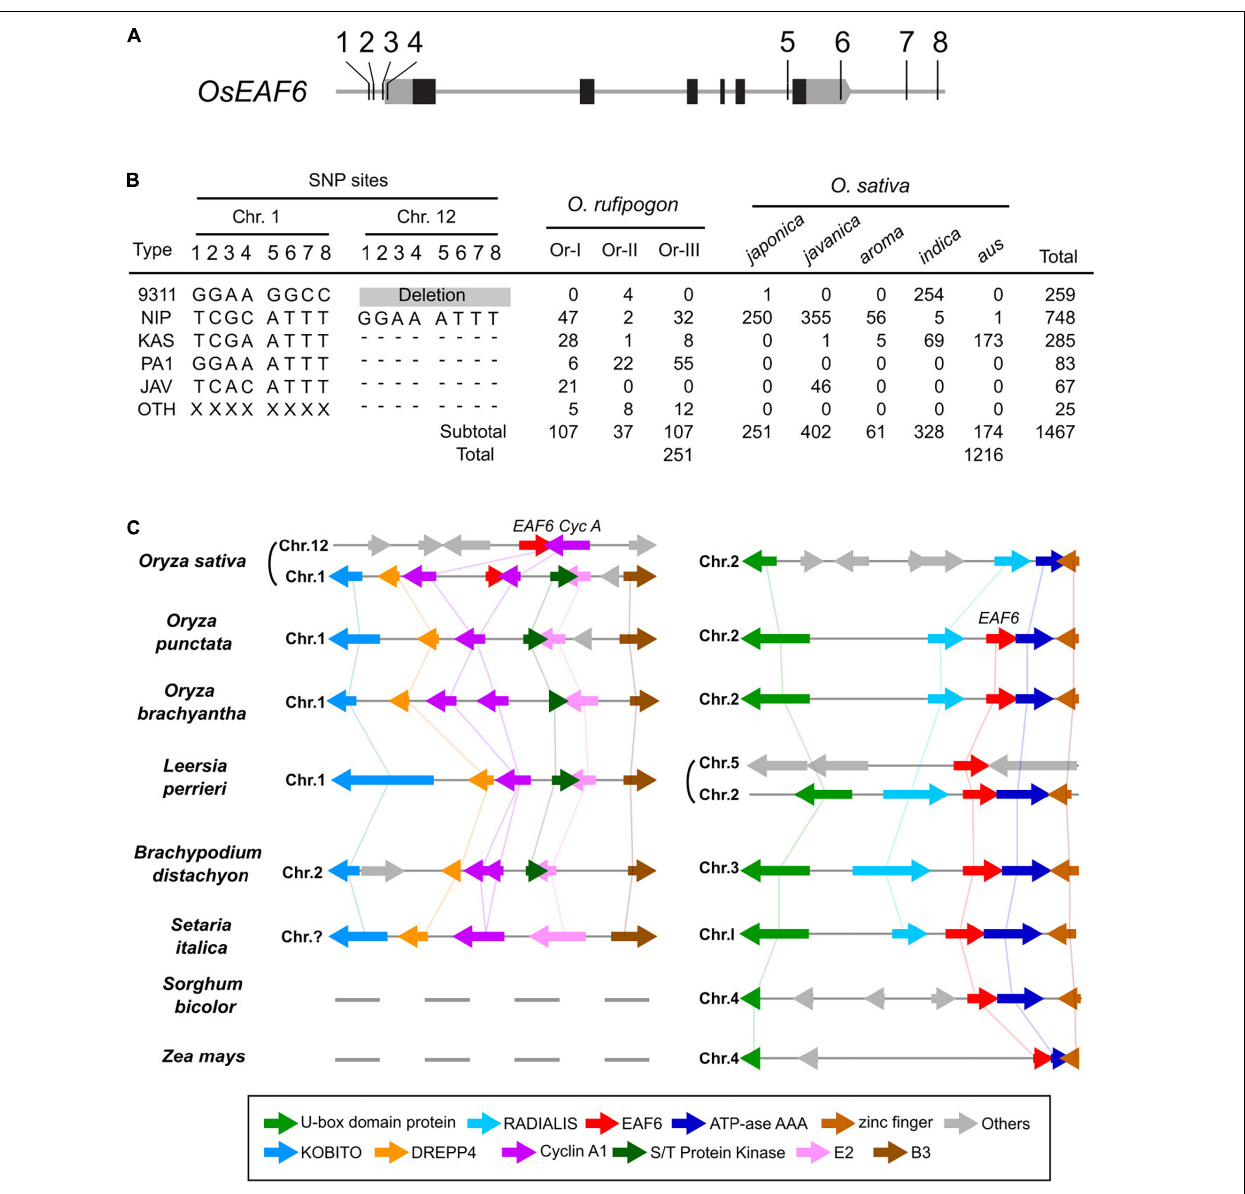
FIGURE 4 | Allele distribution of OsEAF6 and syntenic gene analysis of OsEAF6 region. (A) Distribution of hwe1 and hwe2 alleles in Oryza sativa–Oryza rufipogon complex. Positions of eight SNPs (1–8) on the 5 (cid:48) and 3 (cid:48) regions of OsEAF6 . Gray and black boxes denote UTR and CDS of rice OsEAF6 , respectively. SNP site 1, -309 bp on chr.1 and -304 bp on chr.12; site 2, -299 bp on chr.1 and -294 bp on chr.12; site 3, -205 bp on chr.1 and -206 bp on chr.12; site 4, -157 bp on chr.1 and -158 bp on chr.12; site 5, +2,133 bp on chr.1 and +2,527 bp on chr.12; site 6, +2,494 bp on chr.1 and +2,890 bp on chr.12; site 7, +2,971 bp on chr.1, and site 8, +3,153 bp on chr.12 and +3,555 bp on chr.12. The positions of SNPs (bp) were based on the Nipponbare sequence [+1 refers to (A) in the ATG start codon]. (B) Distribution of six haplotypes of duplicated OsEAF6 in O. rufipogon and O. sativa . We evaluated 251 accessions for O. rufipogon and 1,216 accessions for O. sativa . The six haplotypes based on eight SNP sites consist of 93-11-type (9311), Nipponbare-type (NIP), Kasalath-type (KAS), PA1-type (PA1), javanica type (JAV), and other type (OTH). Hyphens represent identical SNPs with the Nipponbare SNP. (C) Conserved syntenic block harboring EAF6 and adjacent Cyclin-A1 loci. Gene annotation of the region surrounding the EAF6 ( right ) and Cyclin-A1 ( left ) loci in the cereal species. Homologous genes are shown in the same color connected by straight lines.